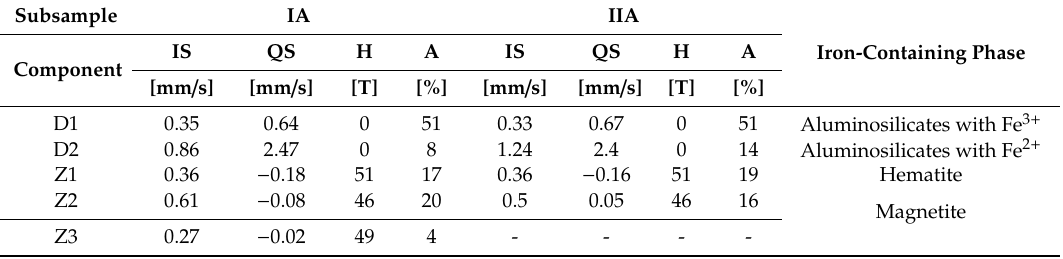
Table 3. Fitted Mössbauer parameters for spectra of samples IA and IIA. IS—isomer shift (with reference to metallic iron), QS—quadrupole splitting, H—magnetic hyperfine filed, A—relative area fraction with respect to whole fitted spectrum. Doublet compounds have been described as D1 and D2 and sexted compounds have been described as Z1, Z2, and Z3.